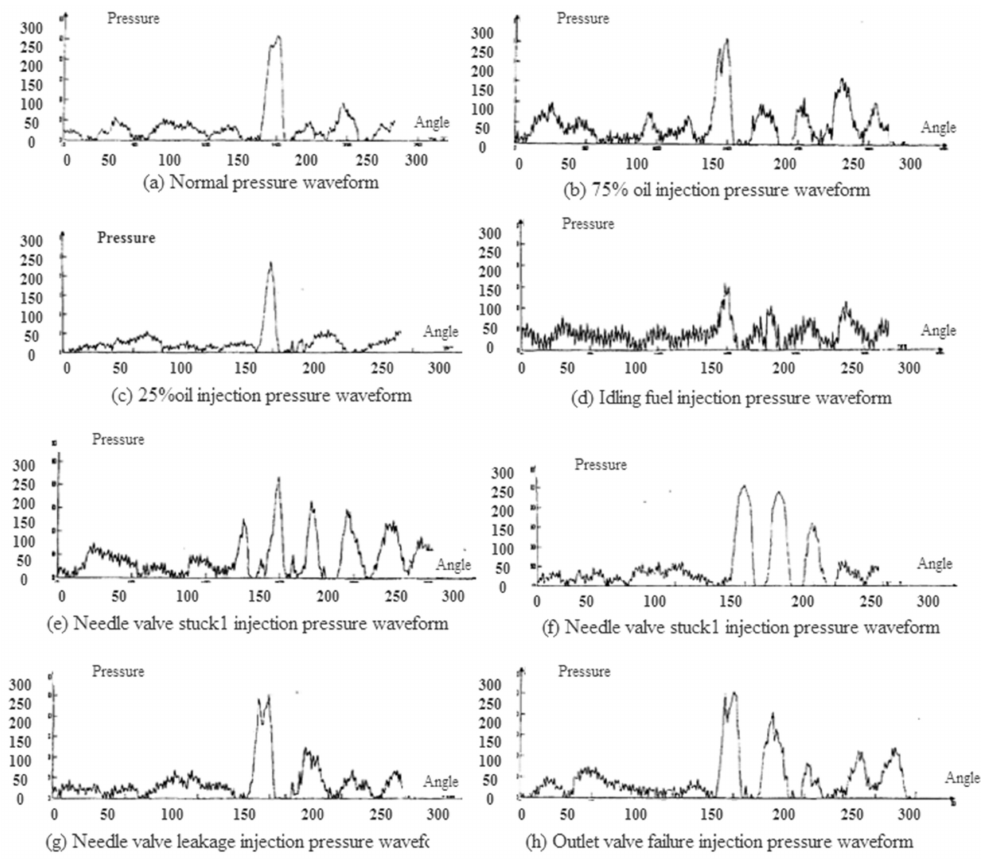
Figure 9. Pressure waveforms for the different states of the marine fuel system.